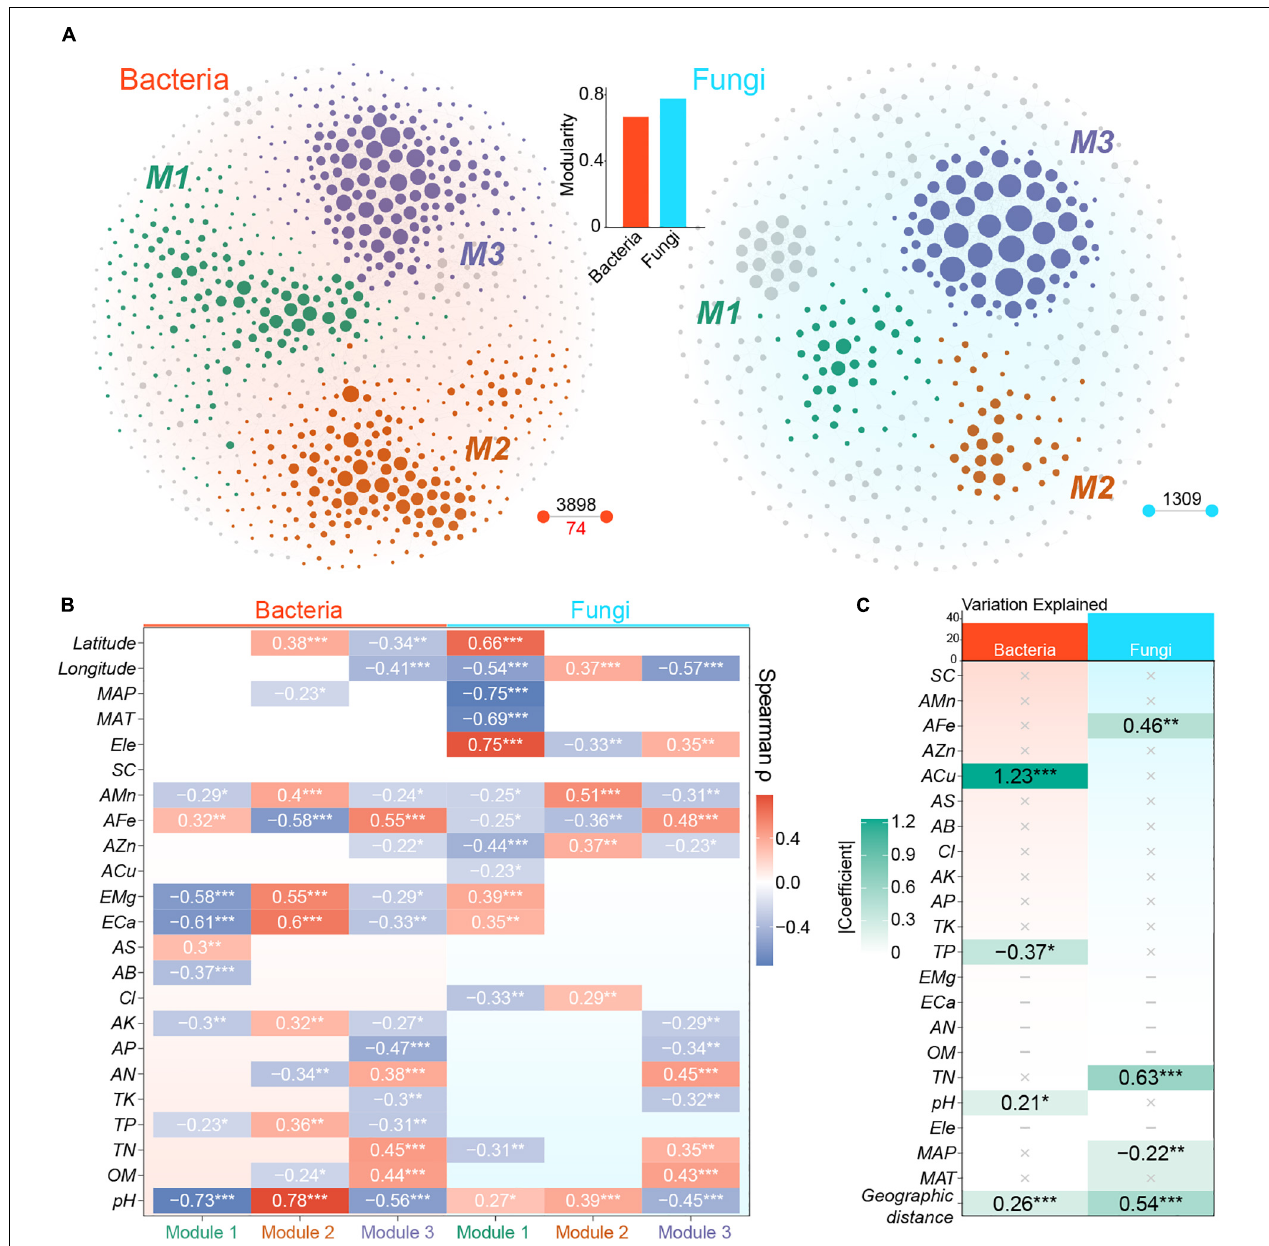
FIGURE 5 | Co-occurrence patterns of bacterial and fungal communities. (A) The co-occurrence networks of bacteria and fungi extracted from cross-domain metacommunity network. Nodes and lines represent OTUs and robust links among OTUs, respectively. Nodes are colored according to dominant modules. Black digits represent the number of positive links, whereas red digit represents the number of negative links. The bar plot represents the modularity of bacterial and fungal metacommunity networks. (B) Spearman correlations between PC1 of modules and measured variables. Modules of bacterial and fungal metacommunity networks are defined in Figure 4A . ( C ) The final result of multiple regression on the Euclidean distance of graph-level topological features of local networks. ‘ × ’ represents non-significant variables and ‘–’ represents variables with strong collinearity. Tile colors are mapped to the absolute values of standardized coefficients. *, P < 0.05; **, P < 0.01; ***, P <